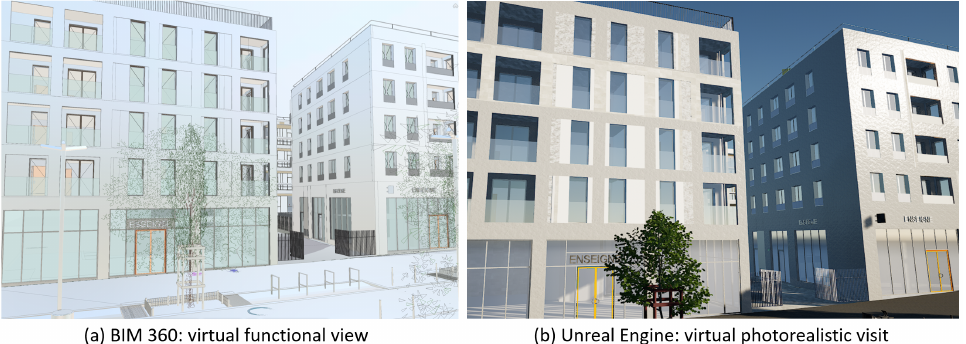
Figure 3. ( a ) AEC traditional view of buildings: perfectly functional, but cold textured. ( b ) The same view produced with a game engine, enhanced in photorealism for a more immersive